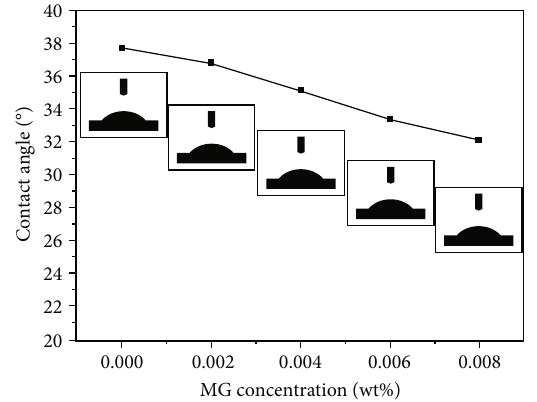
Figure 2: Contact angles of composite membranes prepared with di ff erent GO